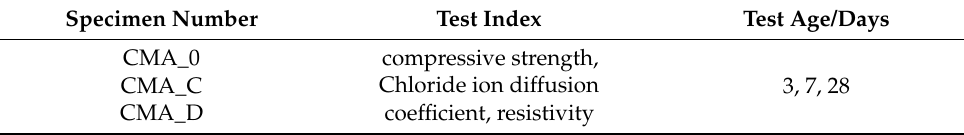
Table 3. Experimental